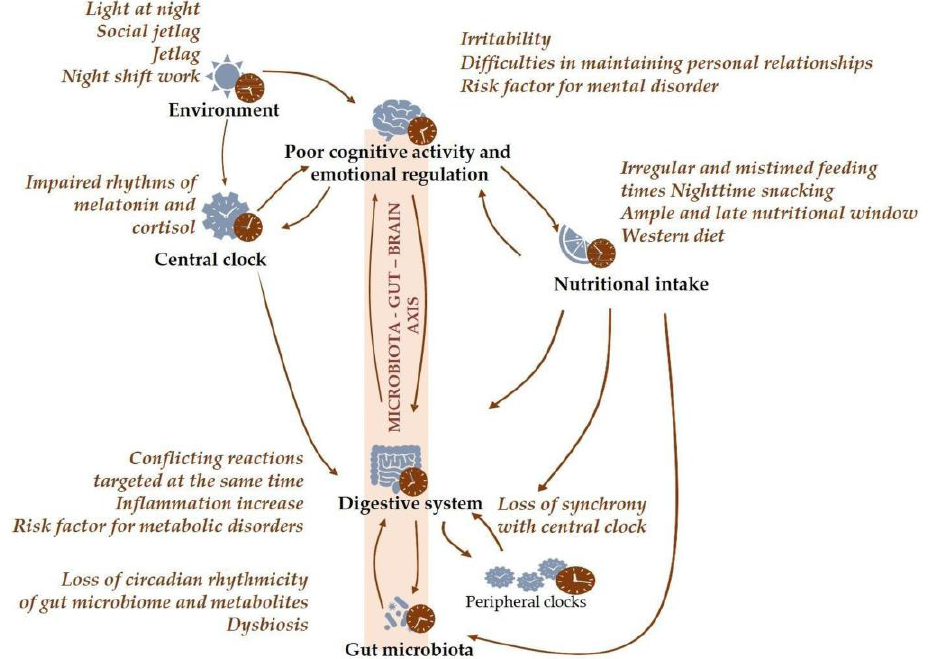
Figure 3. The tight bidirectional link between gut microbiota and circadian system and the impact of disturbances to circadian rhythms or the gut microbiota on host physiology and mental health. Although genetics influence circadian rhythms, lifestyle is a major determinant of circadian health, and factors linked to modern lifestyles can lead to chronodisruption, which often has detrimental consequences on gut microbiota and host physiology, including brain function.